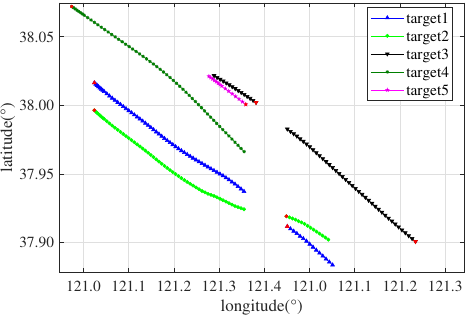
Figure 4. Tracking results using the simulated data.